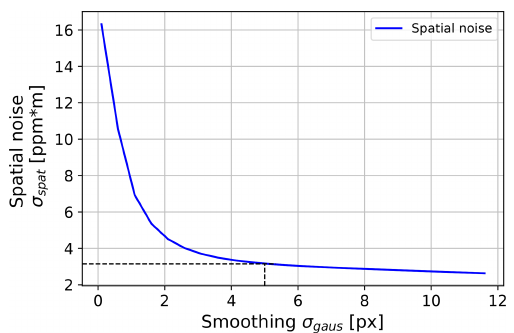
Figure 6. The effect of smoothing the concentration images with a Gaussian blur filter with a standard deviation σ gaus on the spa- tial noise is shown. The distance for the concentration image was 100cm, and the emissivity of the reflective element was 0.4. As a compromise between spatial resolution and noise reduction, σ gaus = 5px was chosen. At a typical imaging distance of 100cm was used, which corresponds to